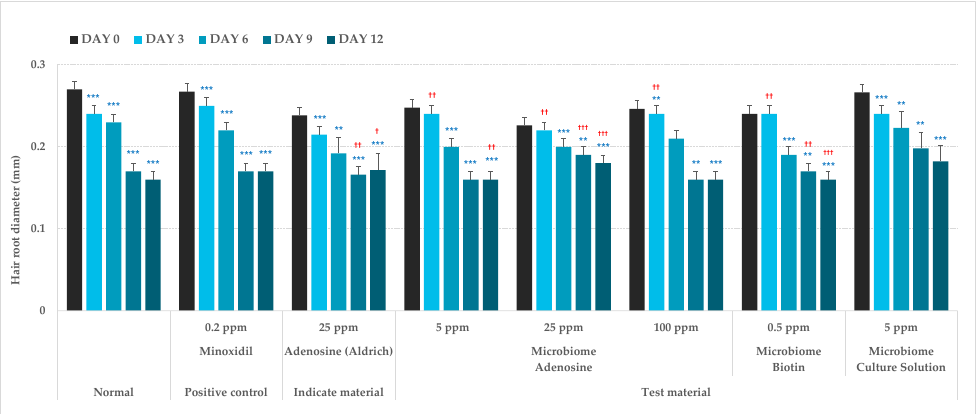
Figure 6. The assessment of hair root diameter (N = 9). ** p < 0.01, *** p < 0.001, † p < 0.05, †† p < 0.01, ††† p < 0.001.